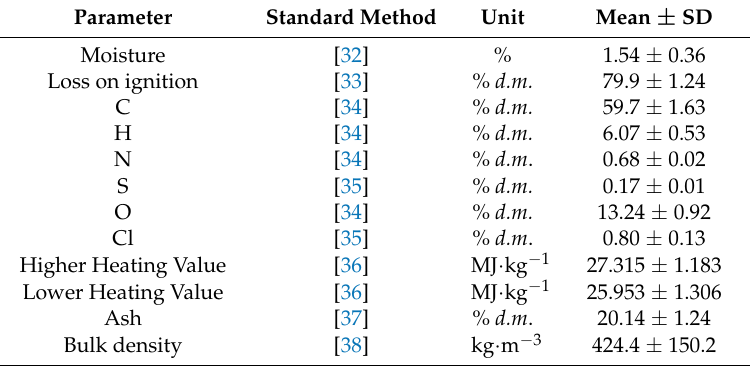
Table 1. Proximate and ultimate parameters of carbonized refuse-derived fuel (CRDF) used in this research, mean ± standard deviation, n =